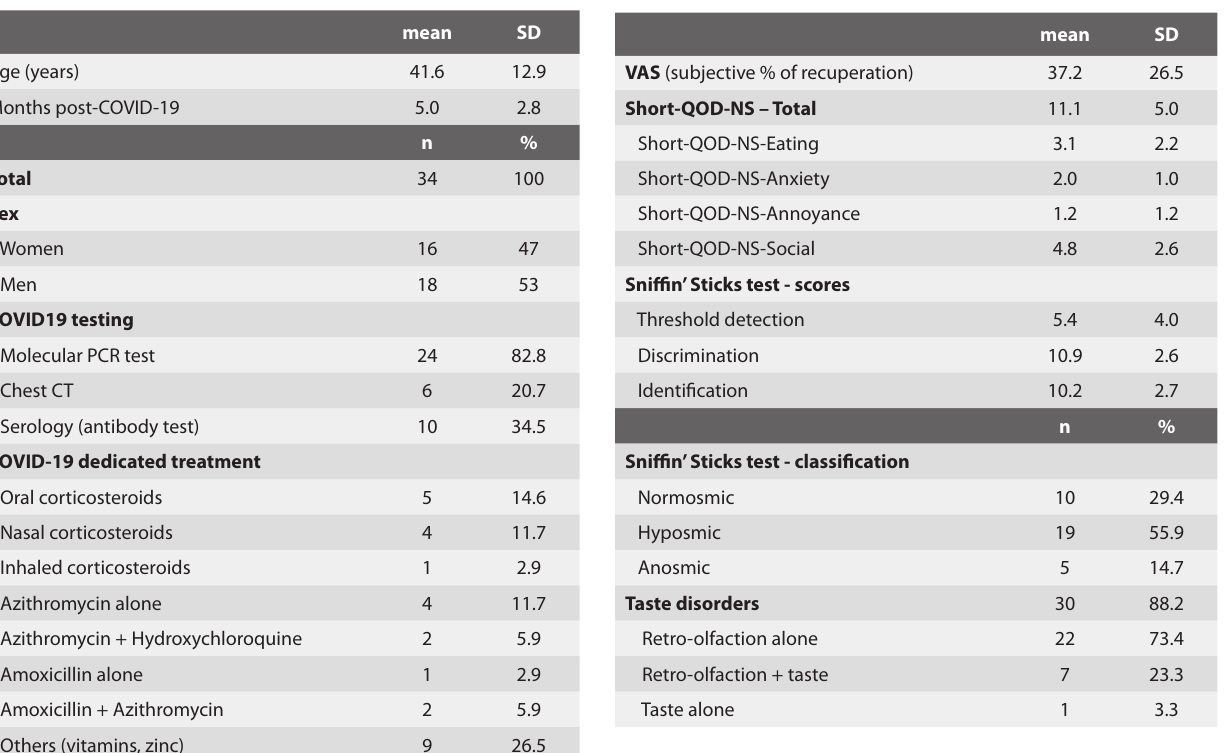
Table 1. Demographic and clinical characteristics. Table 2. Smell and taste disorders, olfactory quality of